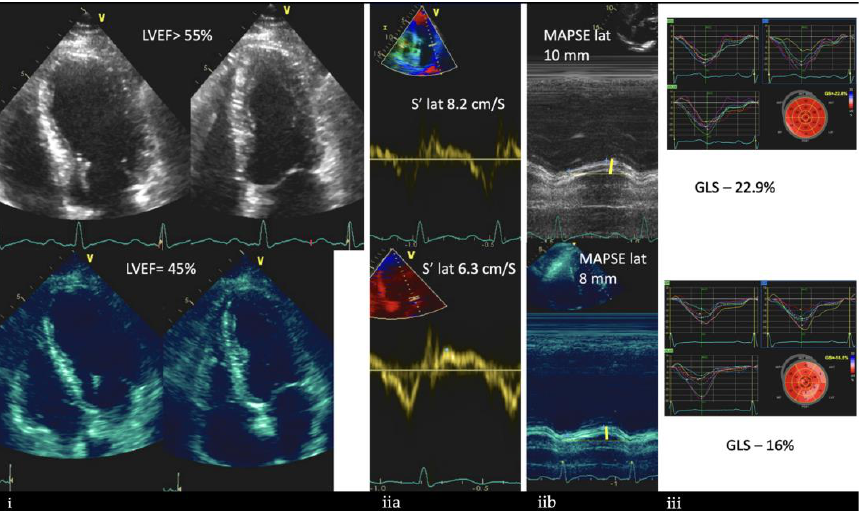
Figure 1. An example of detection and management of left ventricular disfunction (LVD) due to herceptin (anti HER2i) treatment in the case of a 59-year-old woman with breast cancer. In the upper panel, LV ejection fraction (EF), lateral S’, mitral annular plane systolic excursion (MAPSE), and global longitudinal strain (GLS) before chemotherapy are reported. All values were in the normal range. The lower panel depicts the same parameters after two sessions of chemotherapy, showing an impairment in cardiac function. Therefore, the patient started heart failure therapy (b/blockers and ACE-inhibitors); after four months, we observed a full recovery of the LVD. The detection of LVD was determined by the assessment of LV function in 2D using (from left to right): ( i ) EF through the modified Simpson’s method of discs, acquiring LV volumes from apical four- and two-chamber views; ( ii ) linear methods from apical four chamber view via: ( iia ) tissue Doppler imaging (TDI) of the mitral annulus, with sample volume placed 1 cm at the lateral annulus of mitral valve and ( iib ) M-mode on the lateral annulus of mitral valve; ( iii ) GLS, derived from speckle tracking and analyzed by post-processing the apical images of the LV as a myocardial deformation analysis reflecting the sub-endocardial, longitudinally oriented fibers’